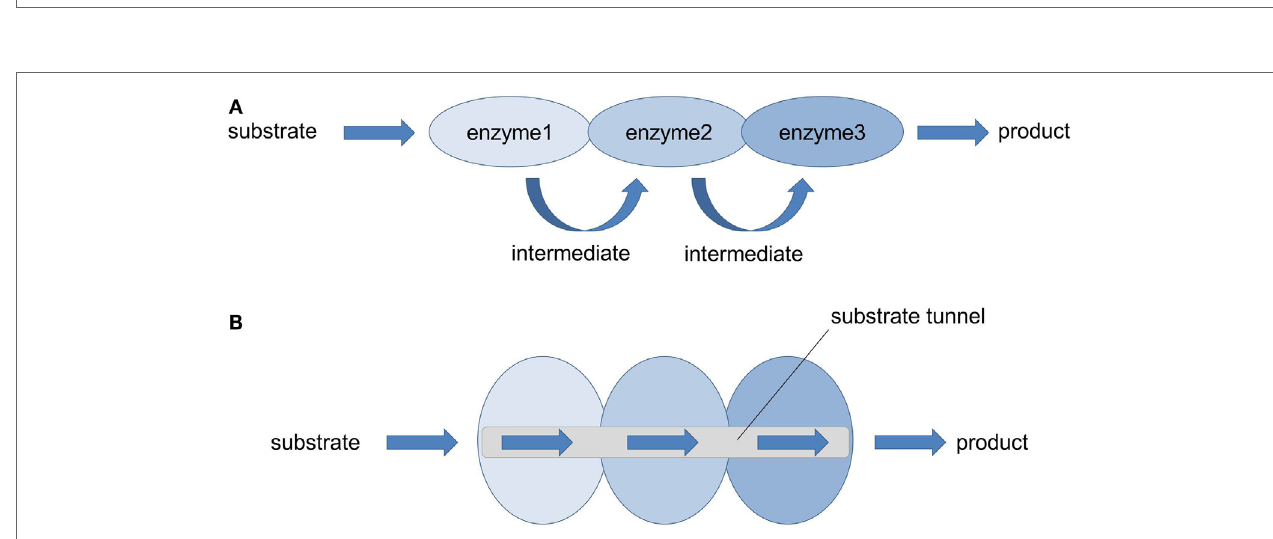
FiGURe 2 | Multienzyme complexes ( = metabolons): nature’s strategy to solve metabolic issues . (A) In nature, many enzymes performing sequential multistep transformation of a substrate are co-localized into multienzyme complexes. Thereby the local concentration of pathway metabolites is increased, the accumulation of pathway intermediates (toxic, reactive, unstable) is limited and the probability of metabolic interference and cross-talk with other cellular components is avoided (Lee et al., 2012). (B) Thanks to the enforced proximity of functionally related enzymes, efficient enzyme-to-enzyme channeling through a substrate tunnel can take place, leading to an increased catalytic performance and product yield.